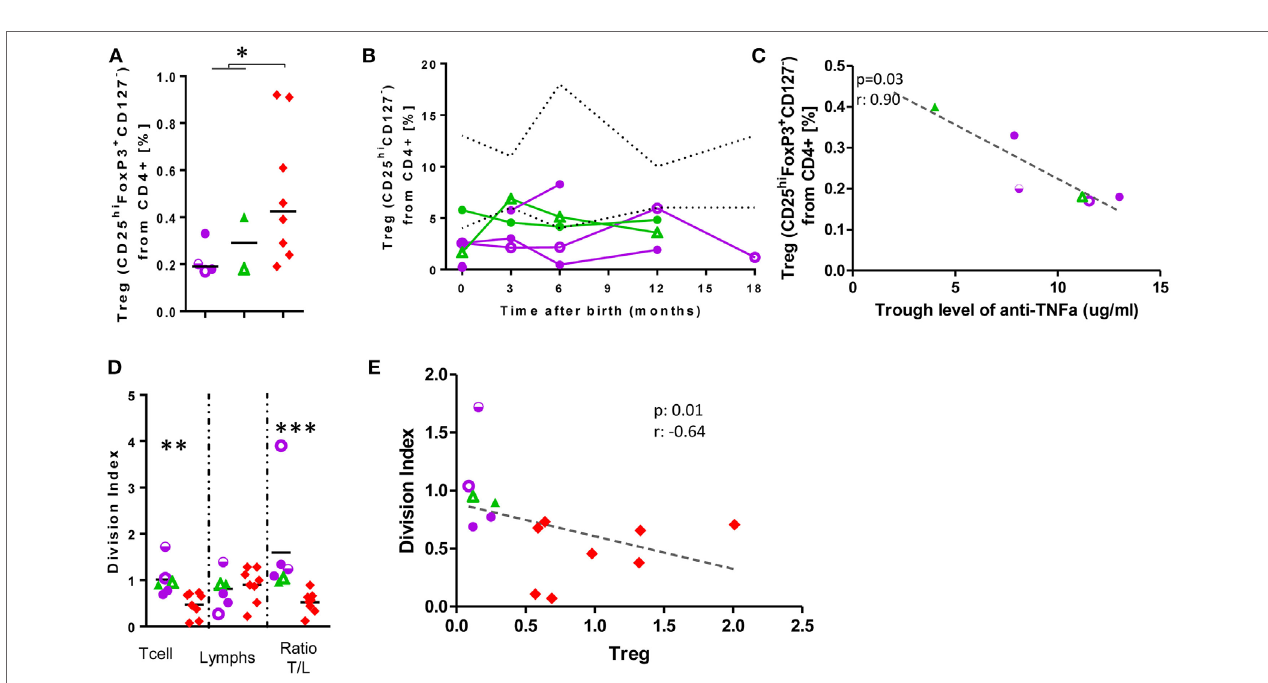
FigUre 4 | Low Treg levels at birth are not rescued and correlate with increased T-cell proliferation. Treg frequency at birth (a) and follow-up (B) . (c) Correlation between Treg frequency and mother’s anti-TNF- α trough level. (D) Division Index after 7-days’ stimulation with ConA. (e) Correlation between Treg frequency and T-cell division index. Dotted lines, described reference ranges; purple circles, adalimumab (ADA)-exposed; green triangles, infliximab (IFX)-exposed; red diamonds, cord blood healthy controls; empty symbols, azathioprine co-exposure; half-empty symbols: prednisone co-exposure. ADA-exposed infants, n = 4; IFX-exposed infants, n = 2.